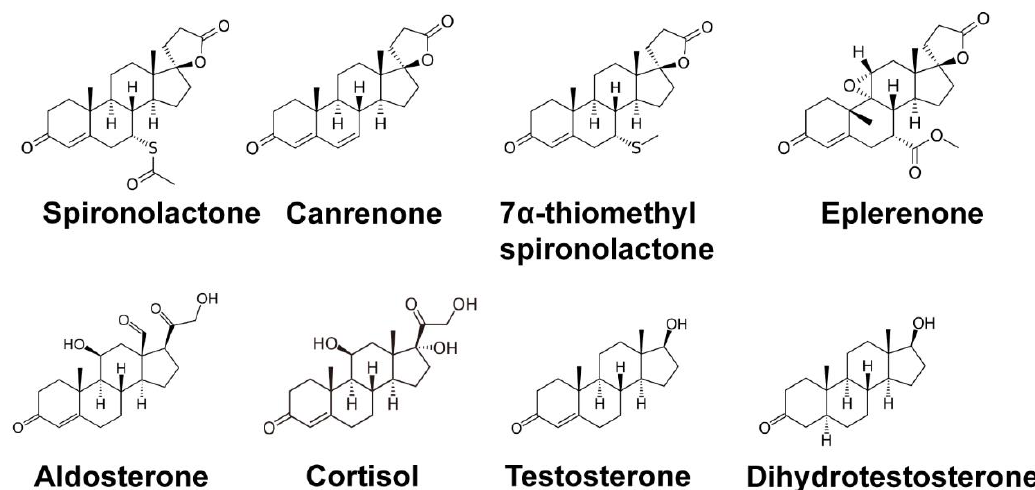
Figure 2. Structures of spironolactone and related molecules. Chemical structures are provided for spironolactone, its metabolites canrenone and 7 α -thiomethylspironolactone, the mineralocorticoid receptor antagonist eplerenone, the mineralocorticoid agonist aldosterone, the related molecule cortisol, and the androgen receptor agonists testosterone and dihydrotestosterone.